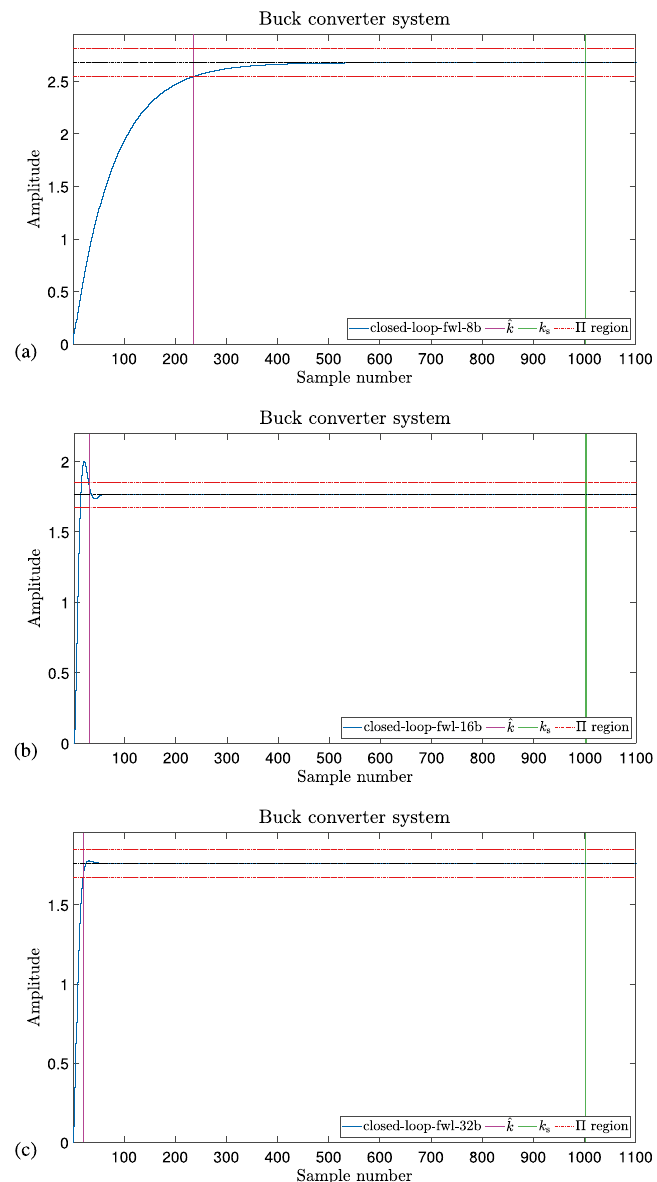
Figure 10. Response output of the buck converter with different FWL effect formats, showing that our controllers meet the requirements. ( a ) FWL (cid:31) 4, 4 (cid:30) ( b ) FWL (cid:31) 8, 8 (cid:30) ( c ) FWL (cid:31) 16, 16 (cid:30)